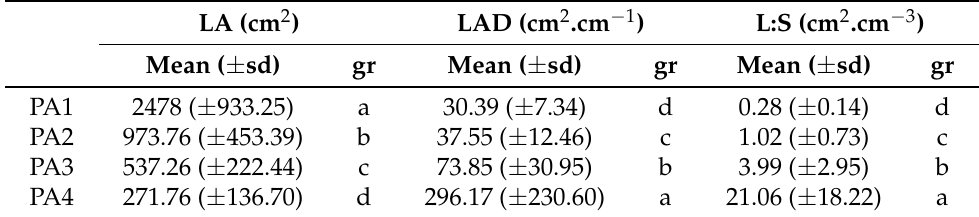
Table 2. Morphological and functional variables as a function of the four annual shoot physiological ages (PA) created with the distribution mixture model. The groups (gr) correspond to pairwise comparisons using the Kruskal–Wallis test with ( α =